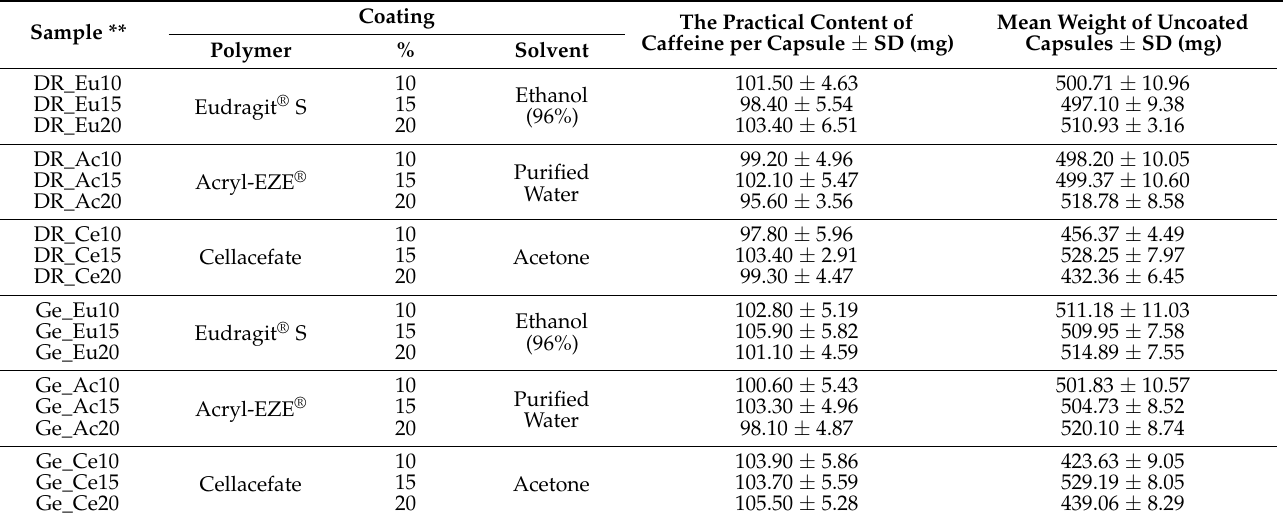
Table 1. Characteristics of prepared hard capsule